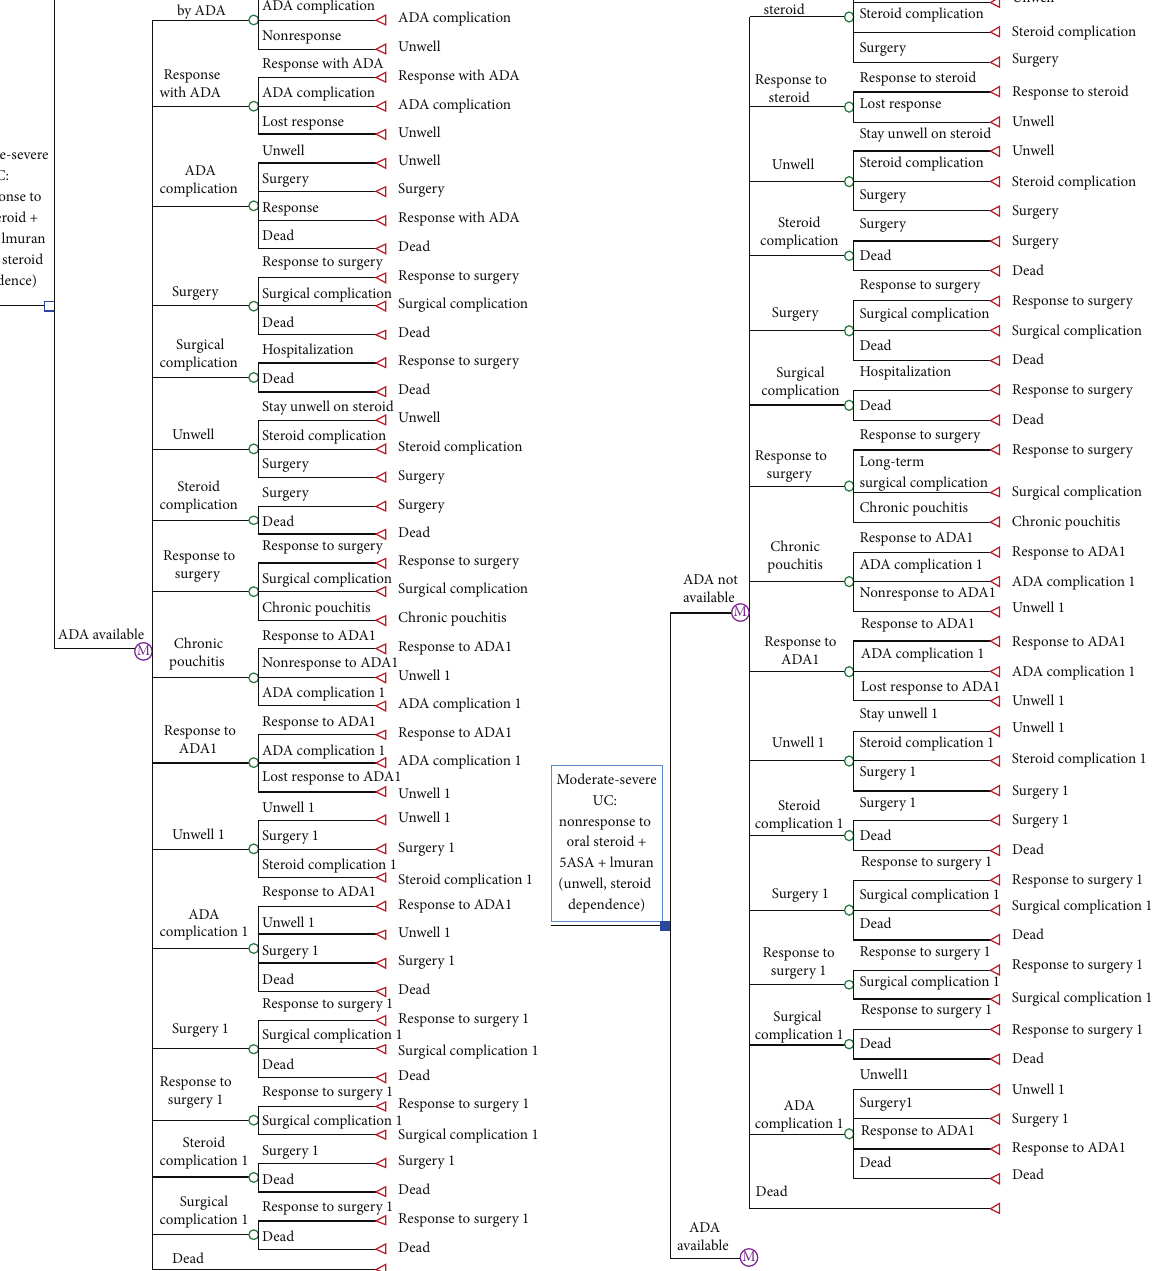
Wellness Drug Benefit List [12]. The costs of corticosteroid, adalimumab, or surgical-complication health states were estimated by averaging the cost of complication weighted by the likelihood of occurrence. Cost of death was counted once and equal to the cost of the health state that led to the death.